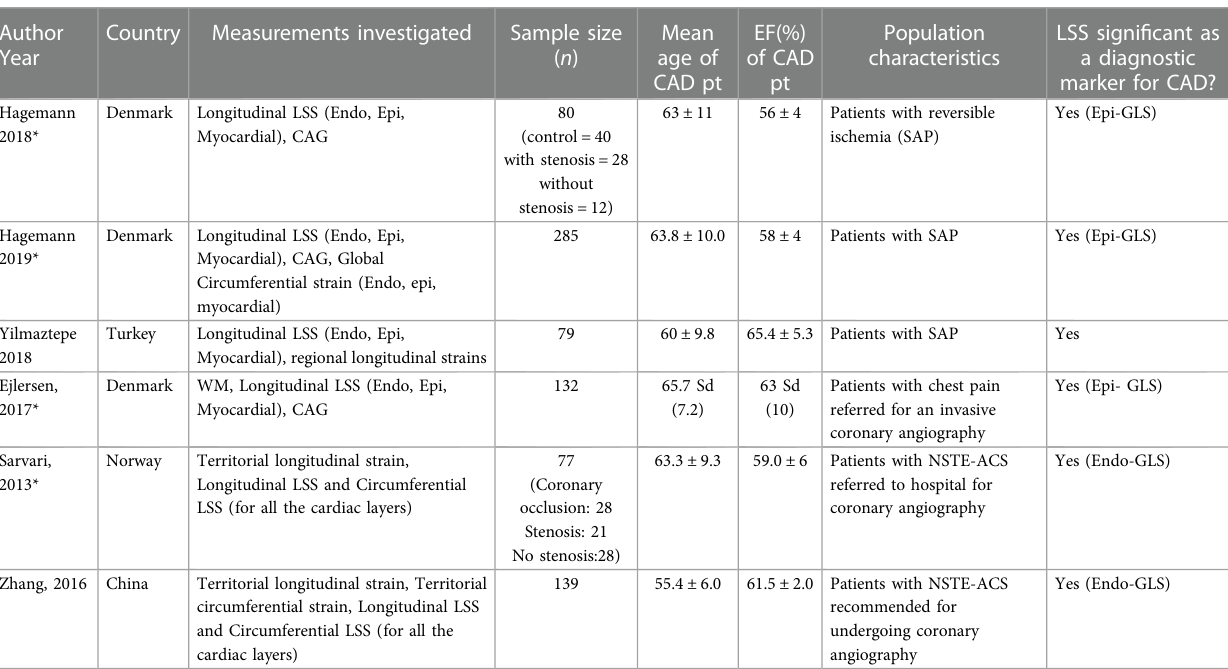
TABLE 1 Studies evaluating the diagnostic signi fi cance of LSS.